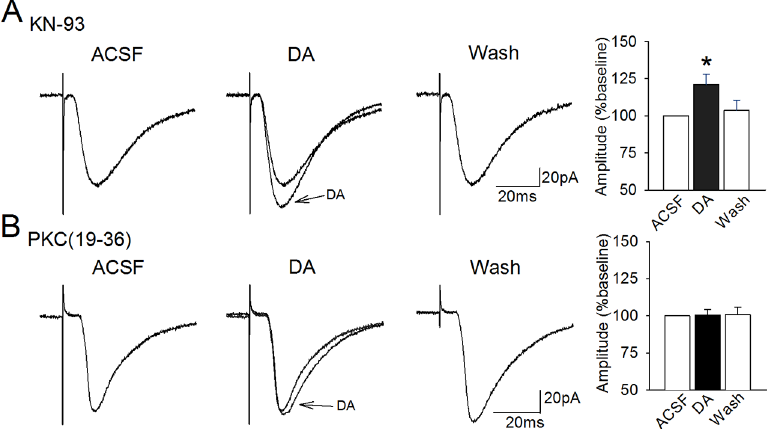
Fig 4. The dopaminergic facilitation is dependent on PKC but not on CaMKII. A. The Ca 2+ /calmodulin- dependent protein kinase (CaMKII) can enhance AMPA receptor function but we found that intracellular